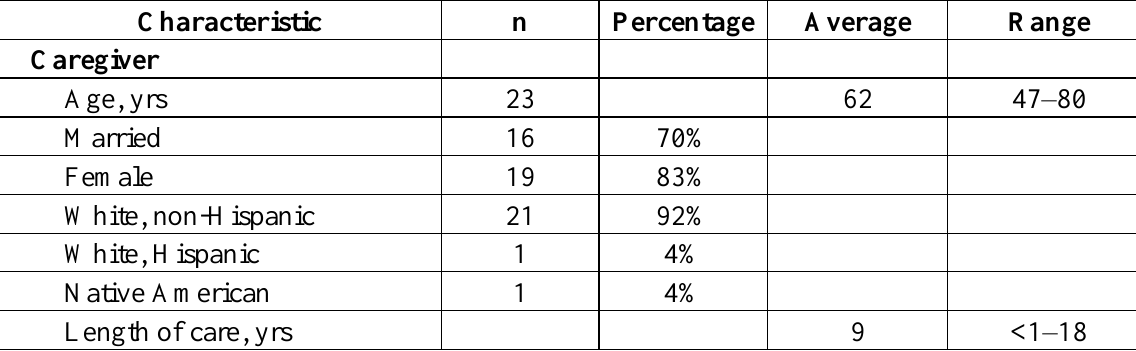
Table 2. Participant